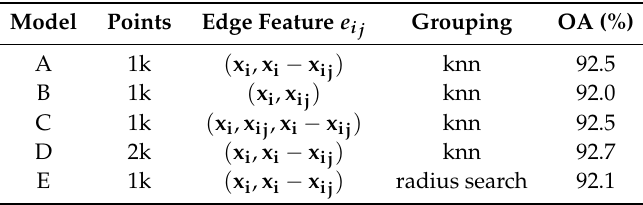
Table 3. Ablation study of